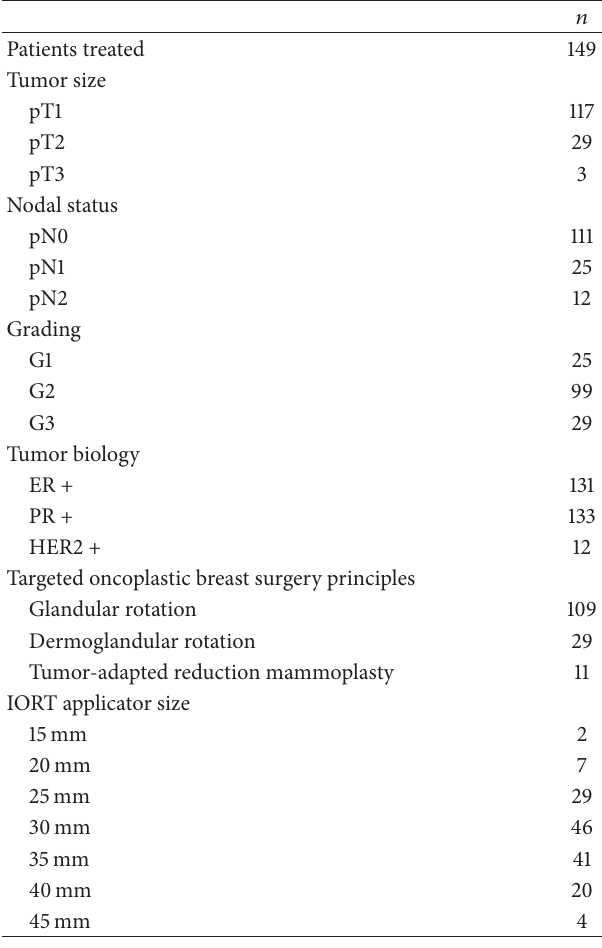
Table 1: Treated tumors and methodological details of IORT